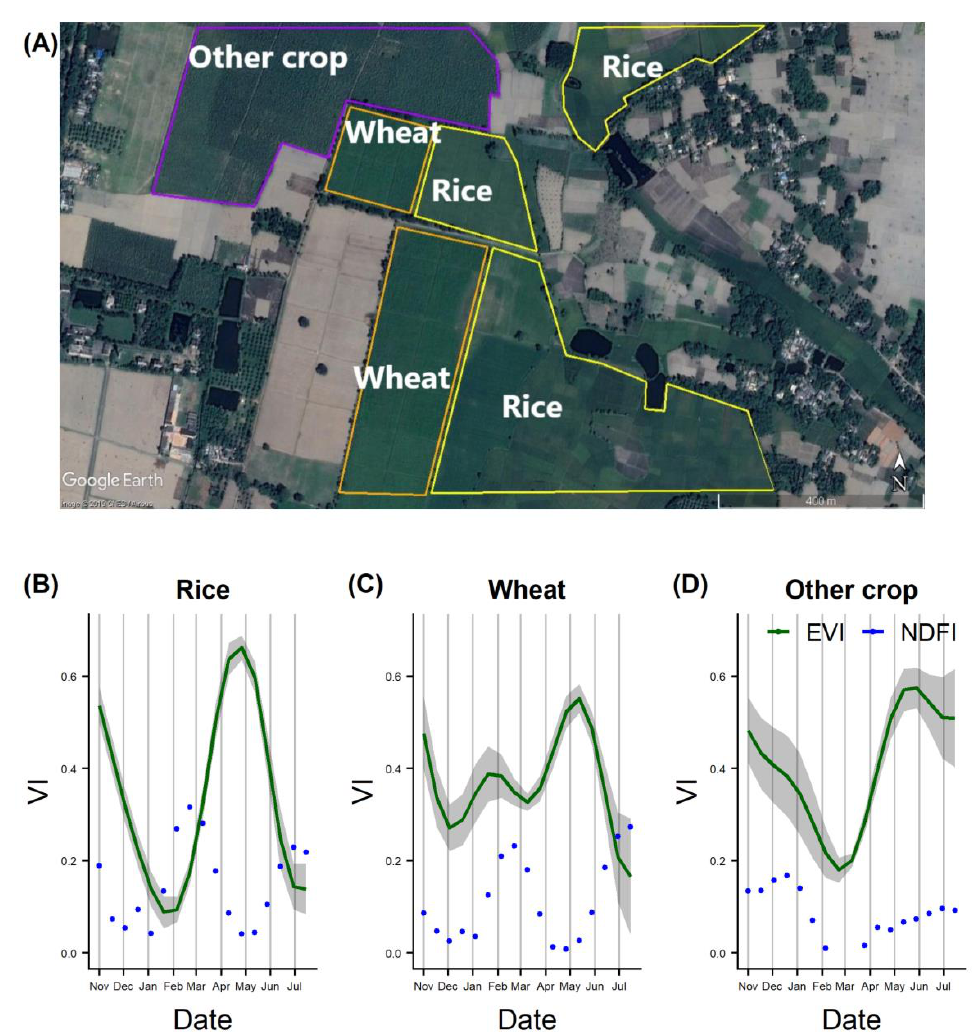
Figure 3. Crop phenology for the boro season with a high-resolution image using harmonic-time- series-based vegetation indices (HTS-VIs). ( A ) High-resolution satellite image from Google Earth in Nashipur (88.67918 N, 25.74691 E), Dinajpur, Bangladesh (near the Wheat Research Centre, BARI). ( B ) Rice phenoplot for the yellow outlined fields in image A. ( C ) Wheat phenoplot for the